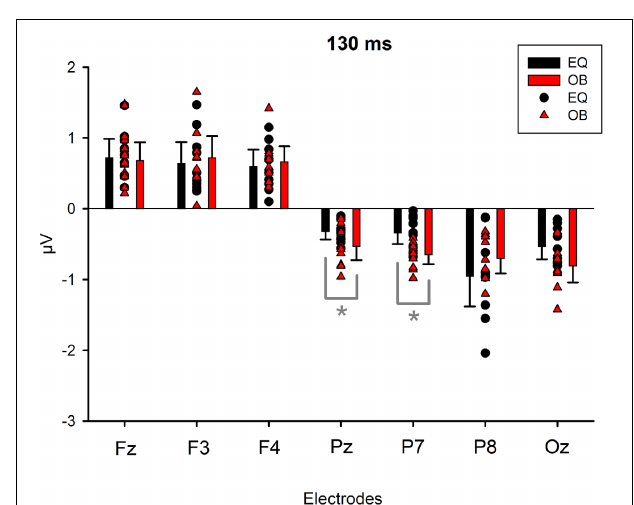
p = 0 . 022 (Bonferroni corrected, mean difference 0.62 μ V, 95%